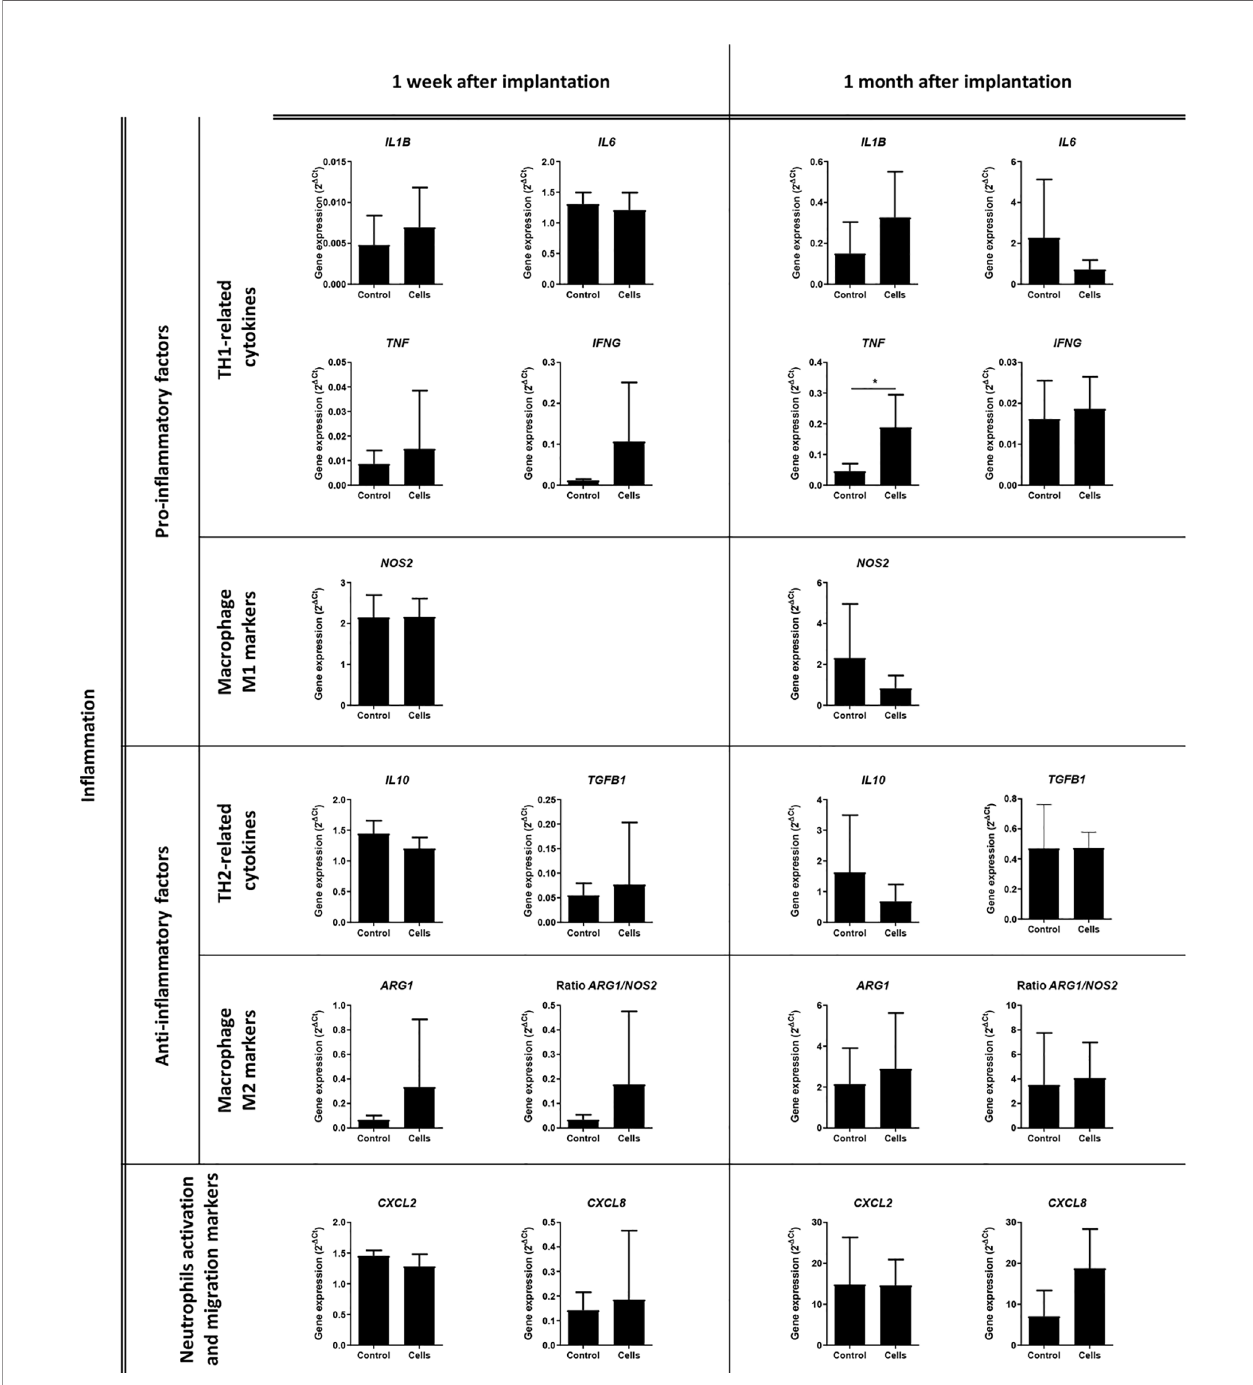
FIGURE 8 | Analysis of the expression of in fl ammation-related genes. Quantitative real-time polymerase chain reaction was performed on the in fi ltrated cells within the surgical meshes 1 week and 1 month after mesh implantation. All the data are presented as mean ± standard deviation. The graphs were created with GraphPad Prism. * p < 0.05 refers to the control group. ARG1, Arginase 1; CXCL2, C-X-C Motif Chemokine Ligand 2; CXCL8, C-X-C Motif Chemokine Ligand 8; IFNG, Interferon Gamma; IL1B, Interleukin 1 Beta; IL6, Interleukin 6; IL10, Interleukin 10; NOS2, Nitric Oxide Synthase 2; TGFB1, Transforming Growth Factor Beta 1; TNF, Tumor Necrosis